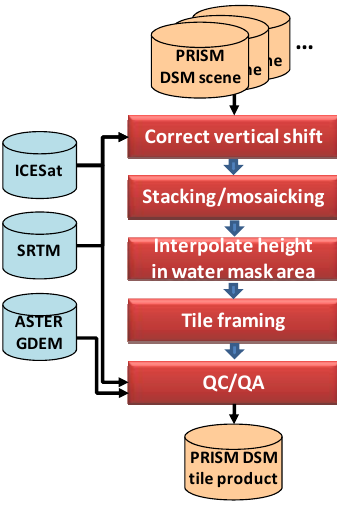
Correct vertical shift